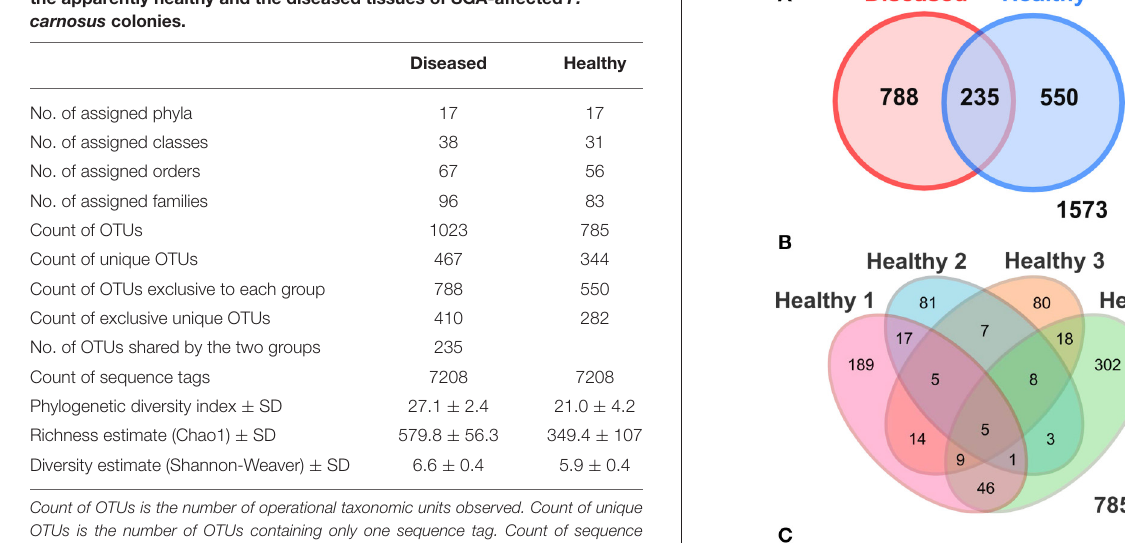
Figure S1). The phylum Proteobacteria represented 42.4%